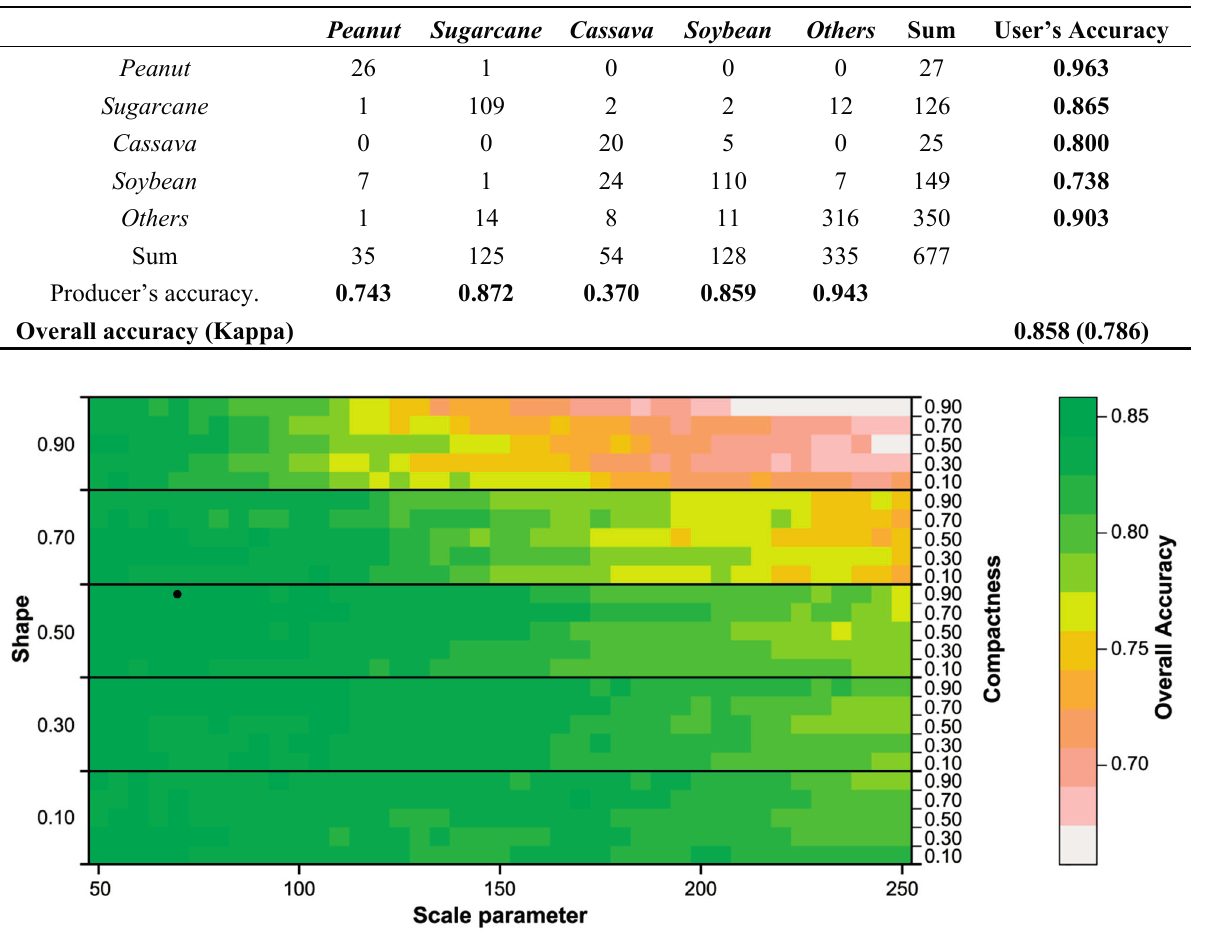
Figure 7. Overall accuracies (OOB) for all combinations of scale , shape and compactness parameter tested in this study combining samples A and B. For plotting purposes, the individual results have been grouped into classes and color-coded. The black dot indicates the overall best (OOB) result at scale = 70, shape = 50 and compactness =